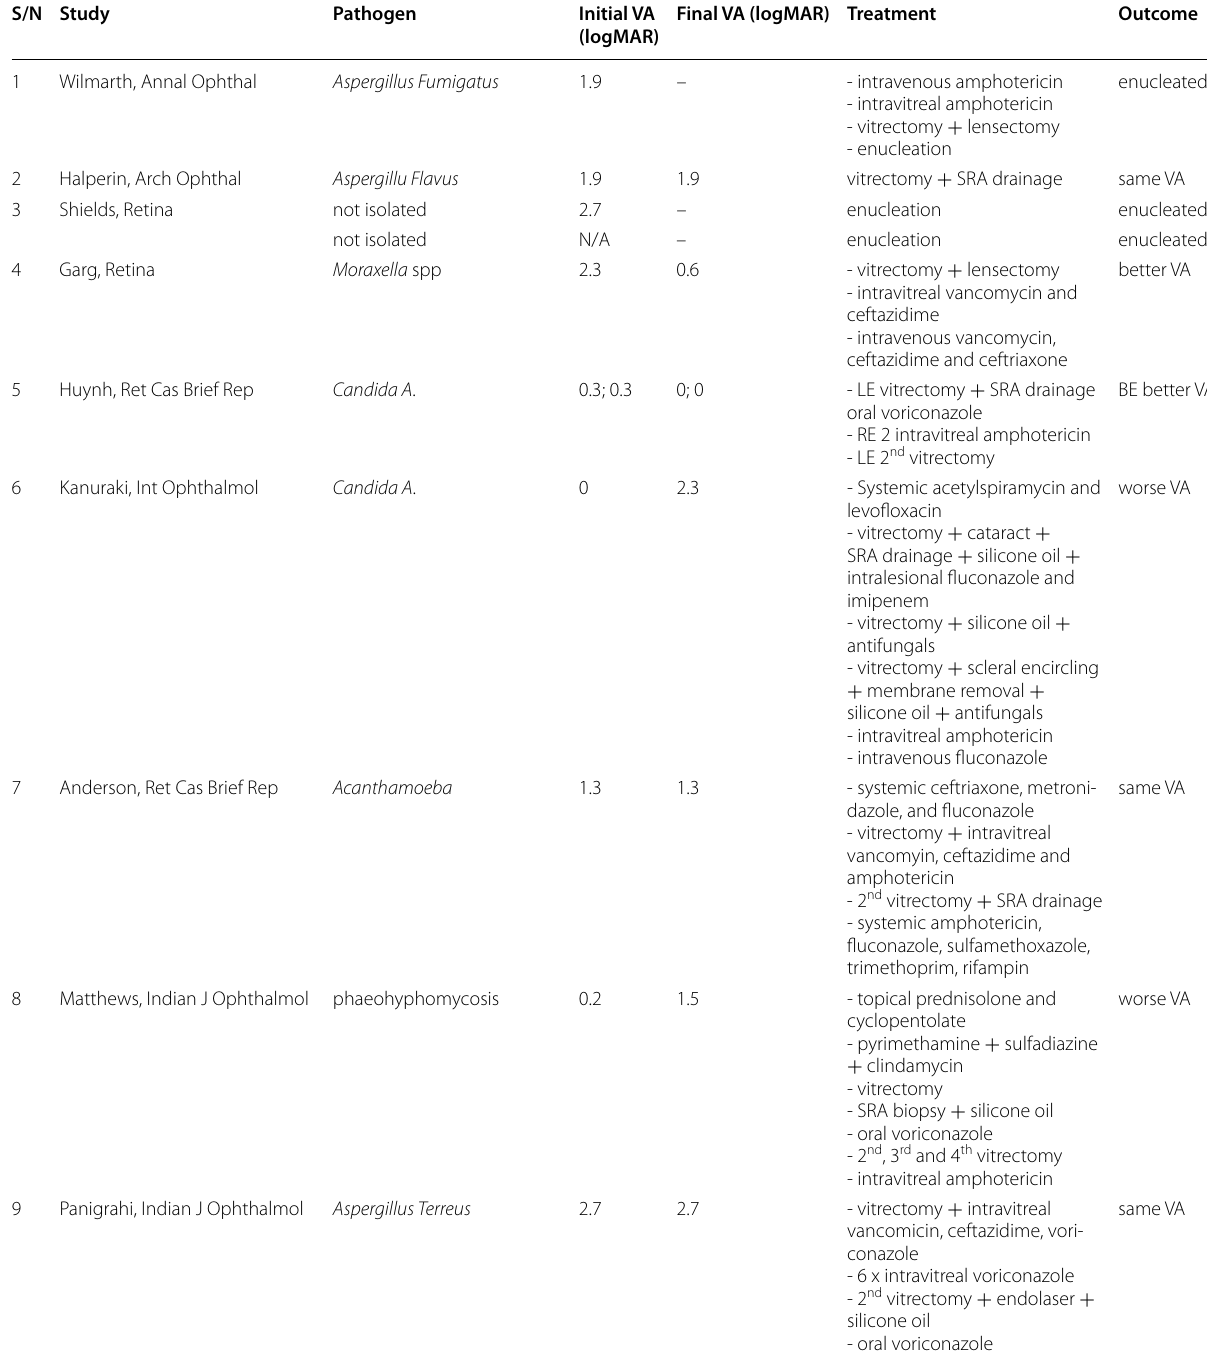
Table 2 Summary of initial and final visual acuity, treatment interventions and final outcomes of SRA without systemic